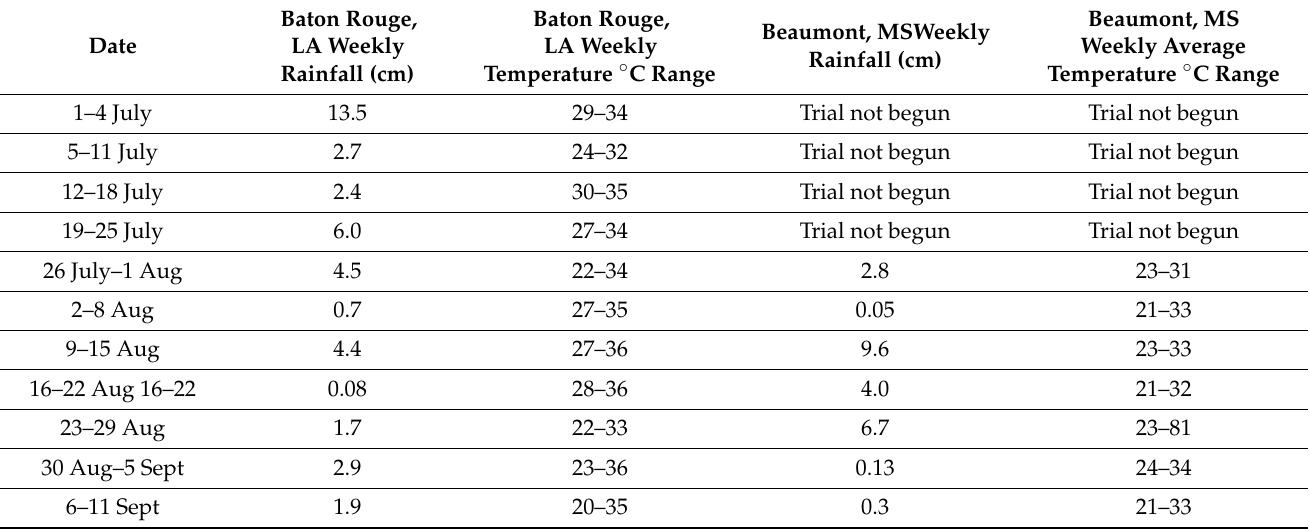
Table 2. Environmental condition differences at the two biodegradable mulch study locations for the 2020 mulch